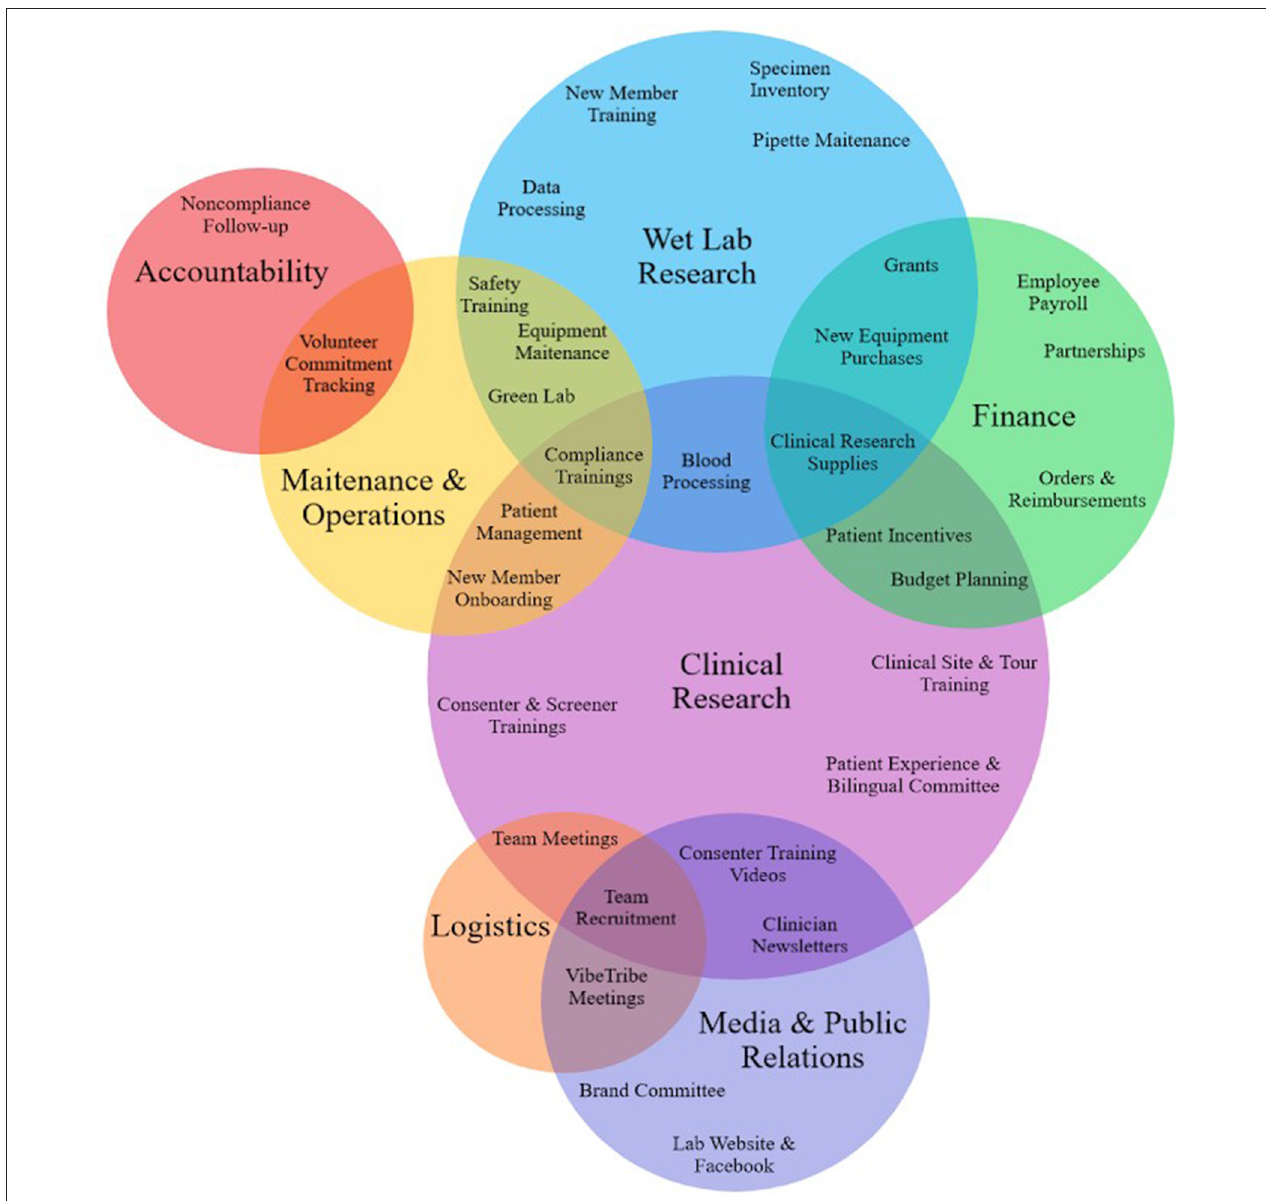
FIGURE 2 | Visual demonstrating the overlapping roles among the lab’s cross-functional committees.